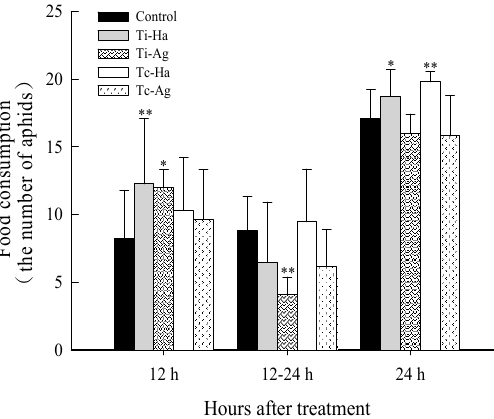
the respective erosion periods lasted 5.3, 0, and 5.15 days, which were not significantly different from the control group (Figure 3b).